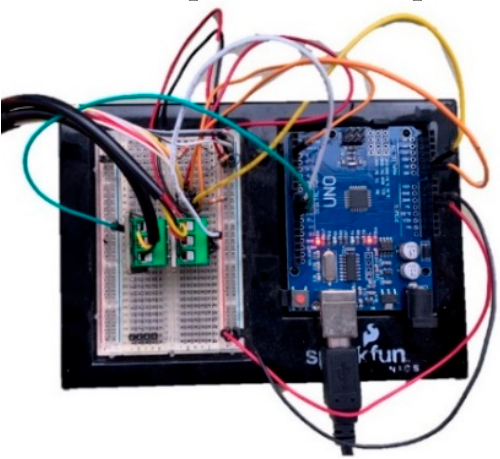
Figure 9. Electronic board wiring to get the data during the tests.